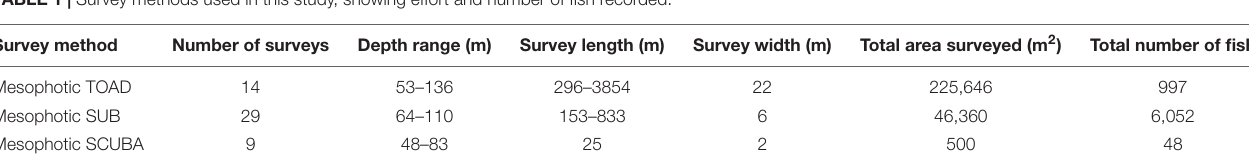
FIGURE 1 | Bathymetry of the Au‘au Channel with survey areas. L¯ana‘i Island is on the left and Maui Island is on the right. TOAD surveys denoted by purple, Submersible surveys in blue, Diver surveys in green and Submersible and Diver surveys in black. TABLE 1 | Survey methods used in this study, showing effort and number of fish